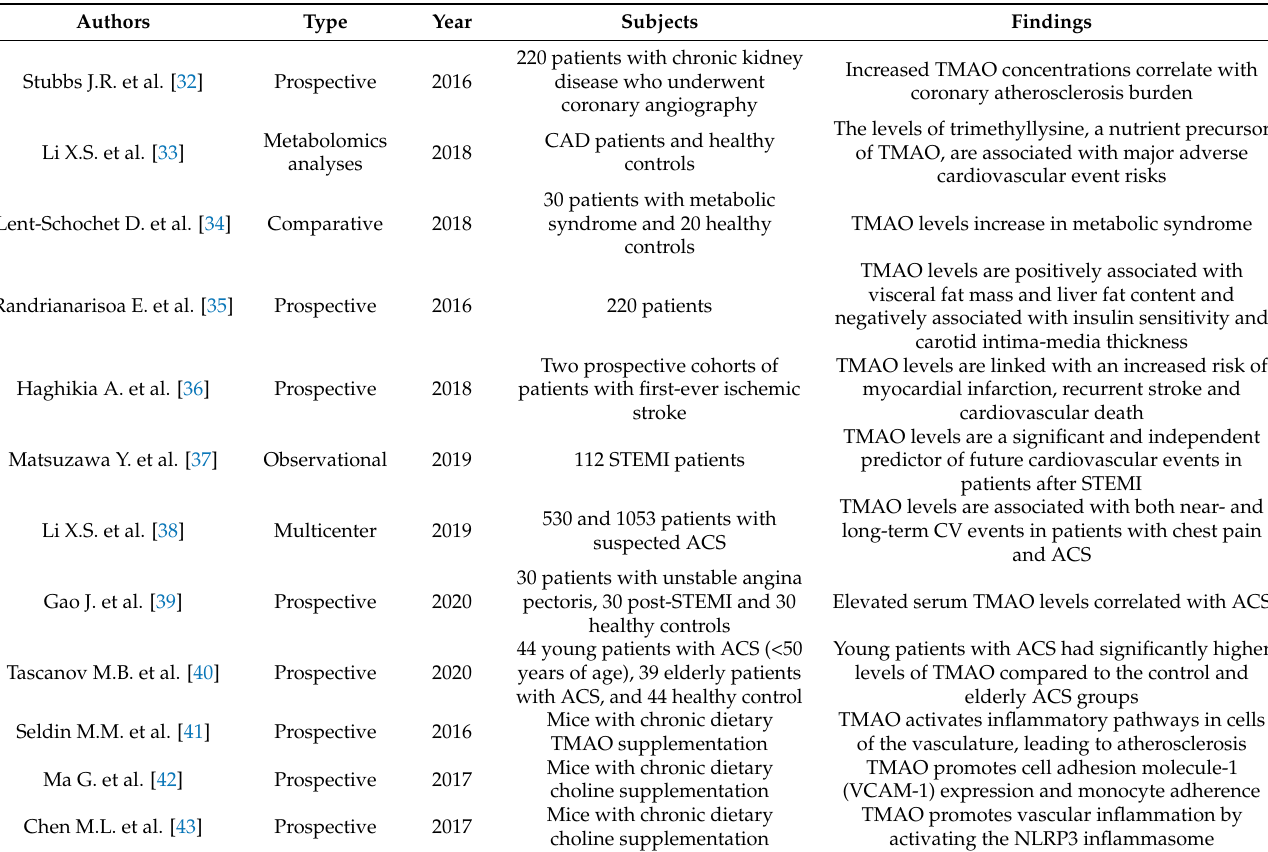
Table 2. Studies on the association between TMAO and cardiovascular